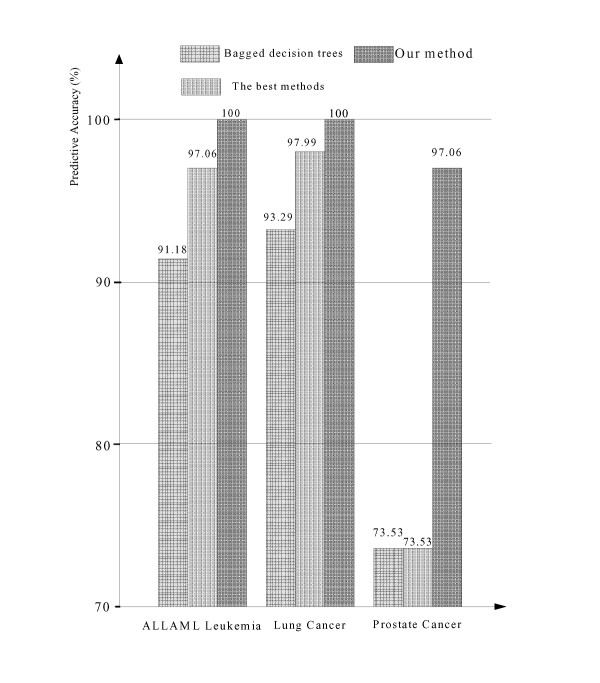
Comparing predictive accuracy of 3 separate testing samples with other methods